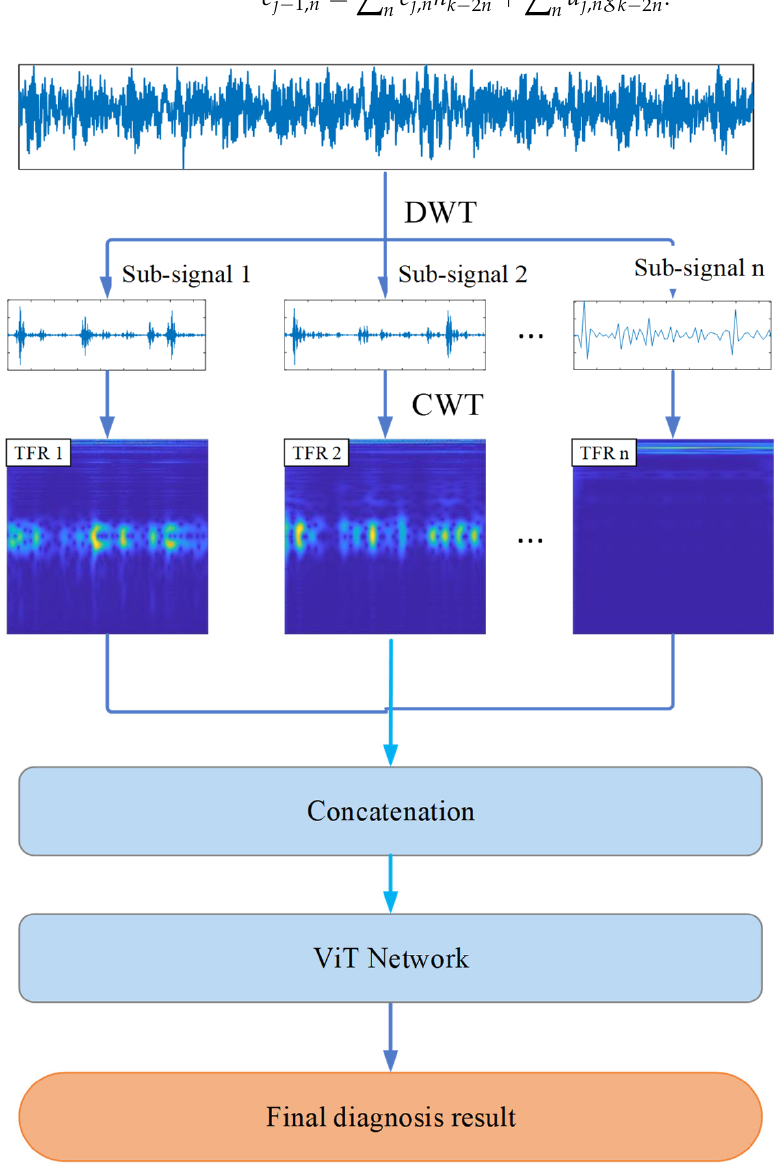
Figure 1. Fault diagnosis scheme based on the proposed multi ‐ information fusion ViT model.